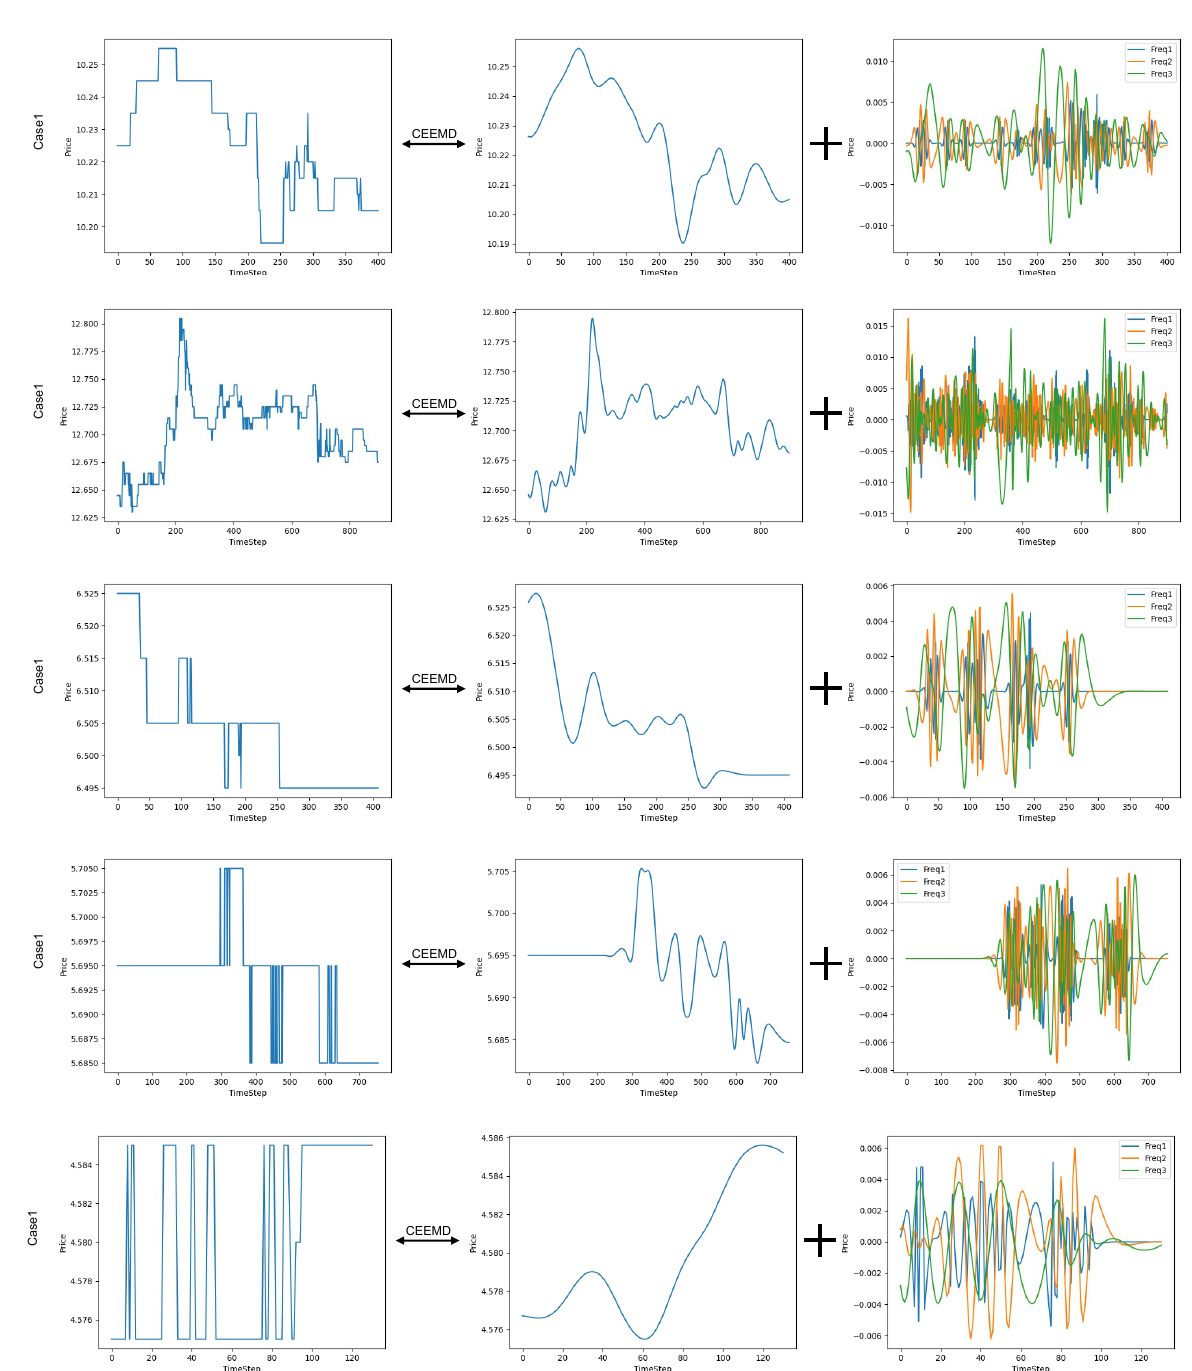
Figure 7. Visualizations of price series after decomposition by CEEMD. From the plot we can see that, series with low or high variance, long or short time steps, it can be decomposed to several more smooth